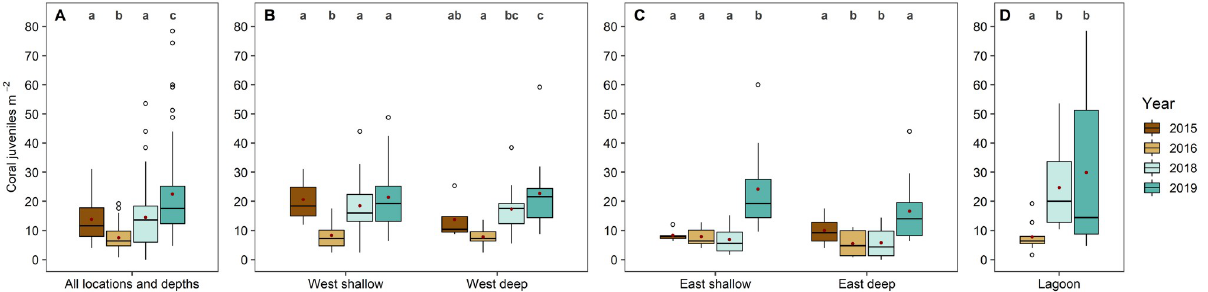
Fig 2. Coral juvenile abundance across locations and years. A: Across all locations and depths; B: Seaward west (2015–2019); C: Seaward east (2015– 2019); D: Lagoon (2016–2019). Plots show median and interquartile range with outliers displayed as circles and means displayed as red dots. Small letters above boxplots indicate significant differences ( p < 0.05) in abundances between years within locations and depths (see S3